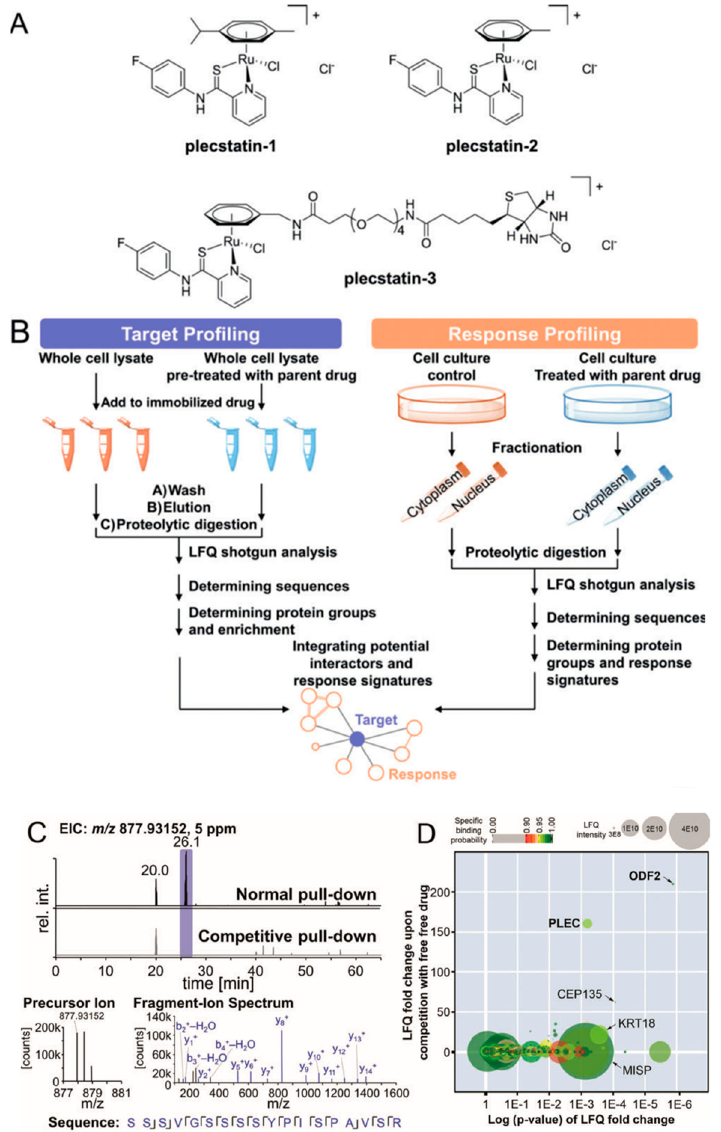
Figure 11. Potential protein targets of ruthenium(arene) pyridinecarbothioamides (plecstatins) were obtained by integrated target-response profiling. ( A ) Chemical structures. ( B ) Schematic representation of the integrated target-response profiling workflow. ( C ) Selected chromatograms and mass spectra of a plectin-specific tryptic peptide. ( D ) Plot of the target profiling experiment. PLEC: plectin; ODF2: outer dense fiber protein 2. This figure is adapted from reference [49].